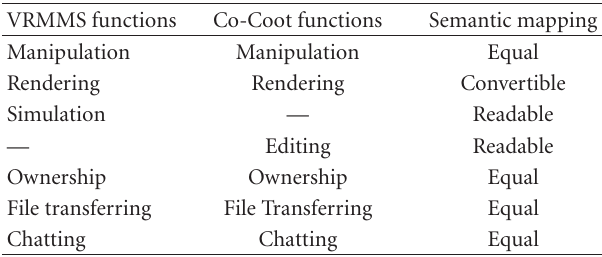
Table 3: Function mapping between VRMMS and Co-Coot. VRMMS functions